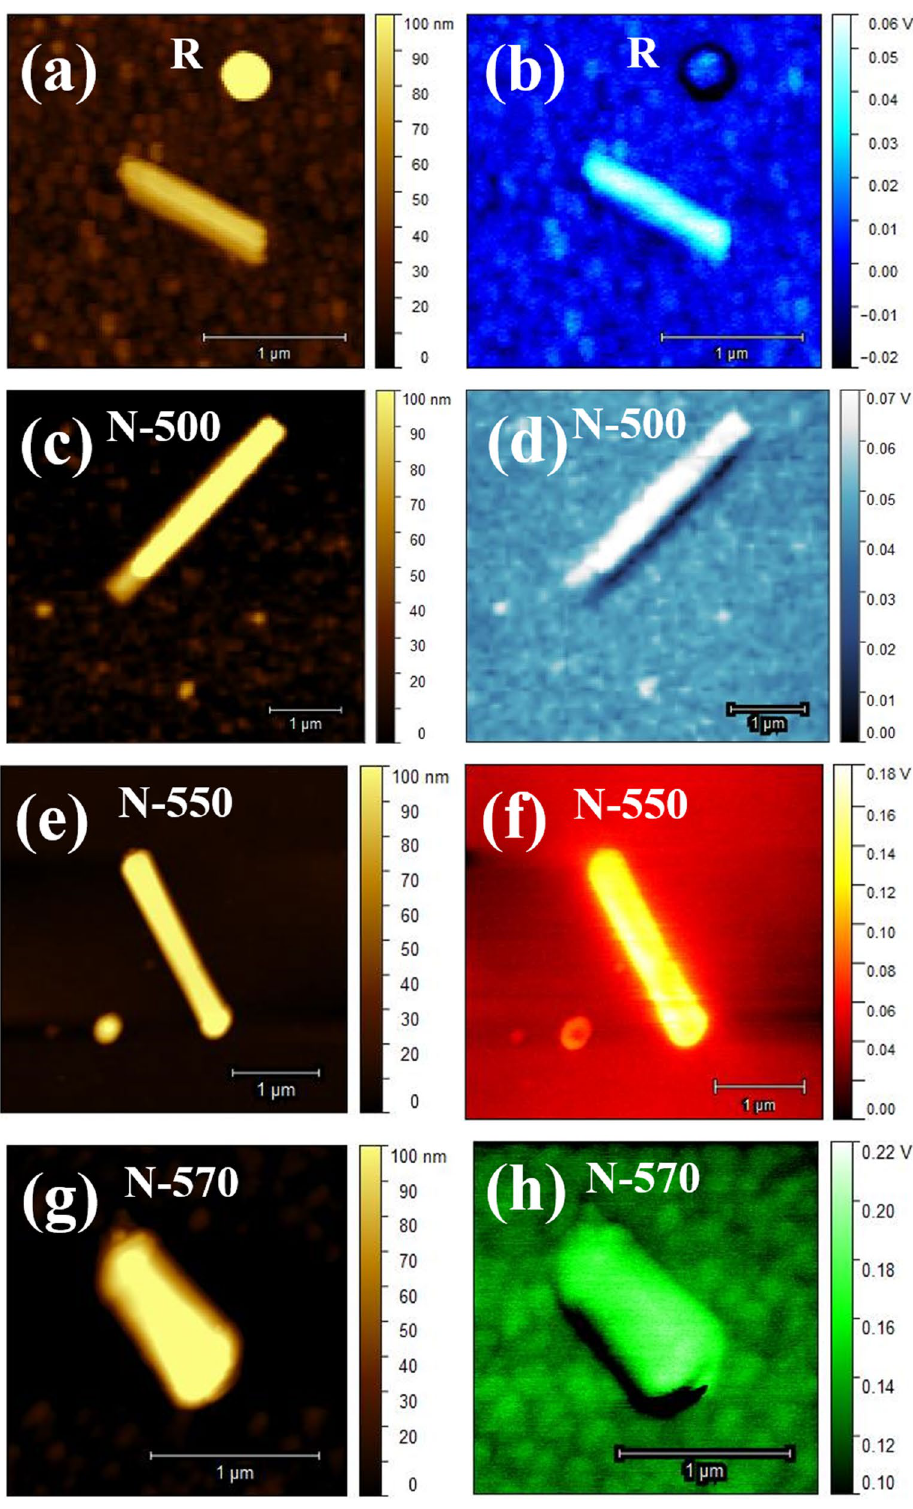
Figure 7. ( a , c , e , g ) Topography and ( b , d , f , h ) corresponding surface potential map of R, N-500, N-550, and N-570 sample, respectively, using